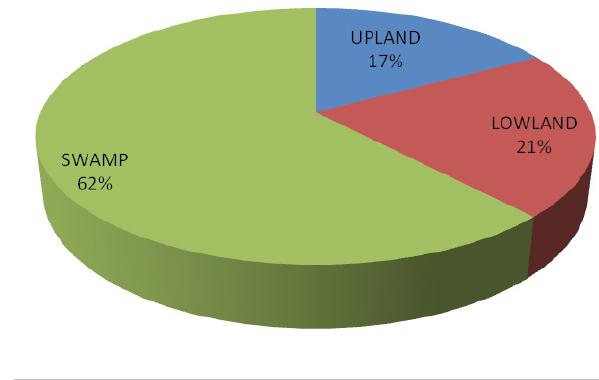
Figure 2: Distribution of rice farmers by production system . Source: Own computation based on field survey (2015)